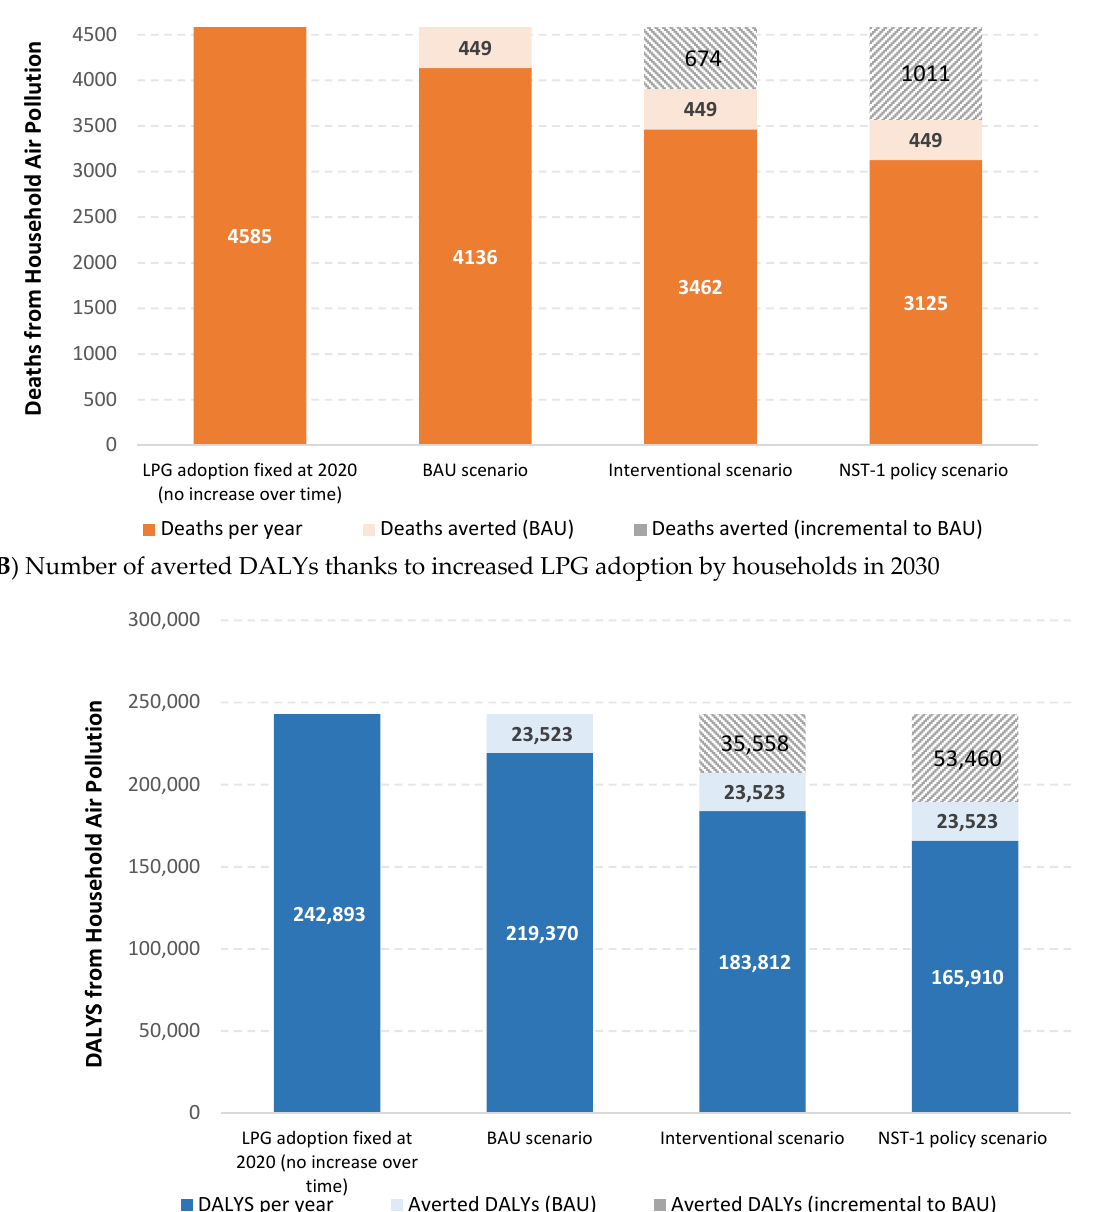
Note: This is an approximation and the figures reflect only projected benefits for use of LPG at the household level, not